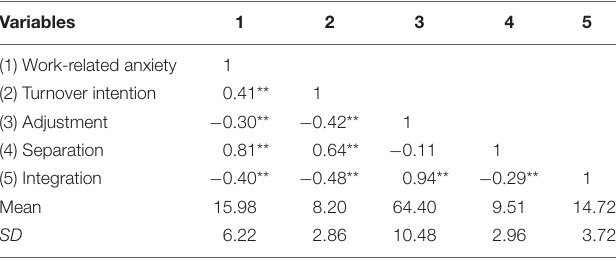
TABLE 4 | R 2 increase due to interaction (work-related anxiety).